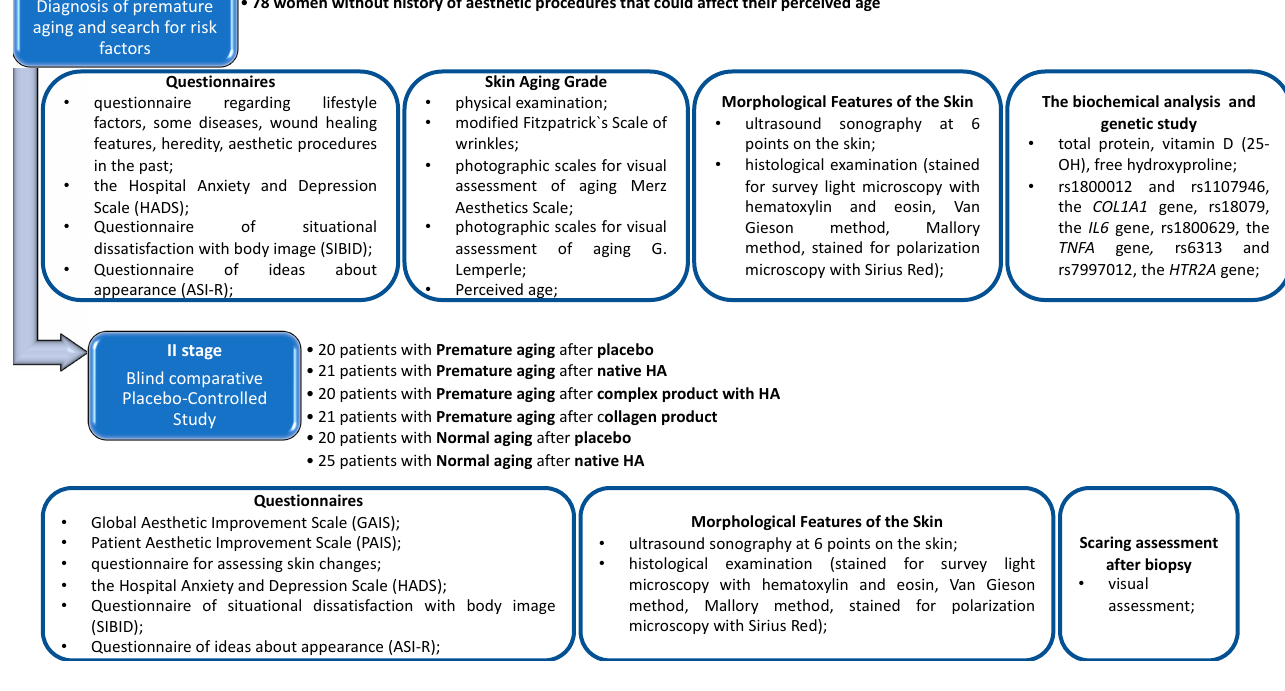
Figure 1. The study designs: stages, study sampling, methods.